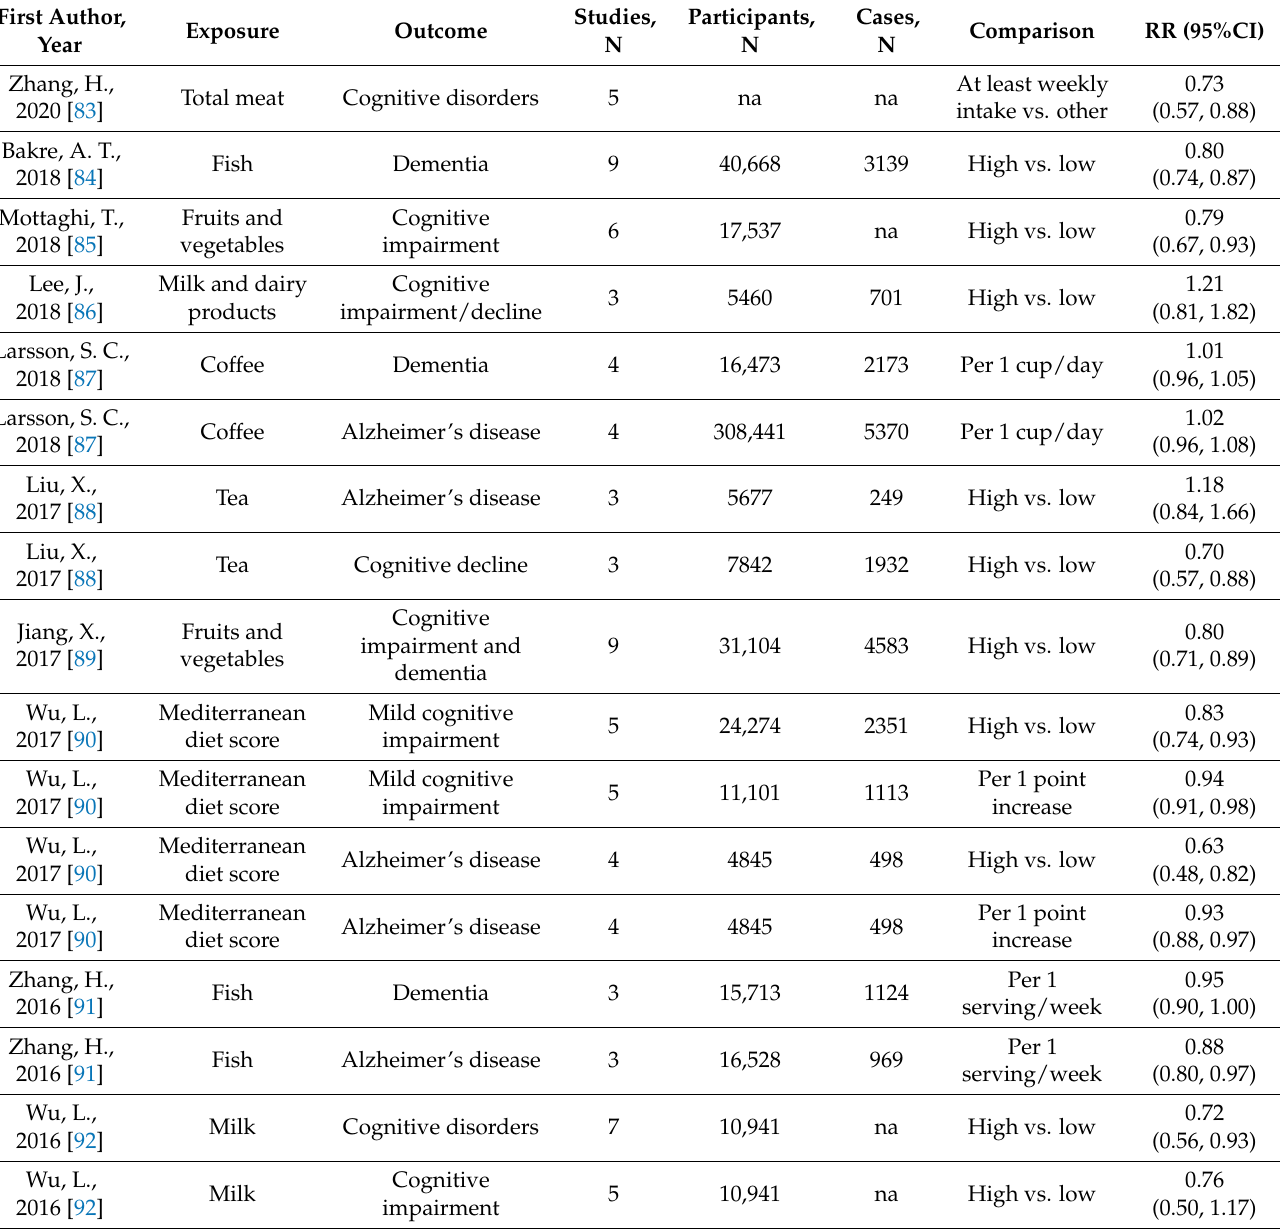
Table 2. Meta-analyses of epidemiological and/or intervention studies evaluating the role of the Mediterranean diet and specific food groups on cognitive